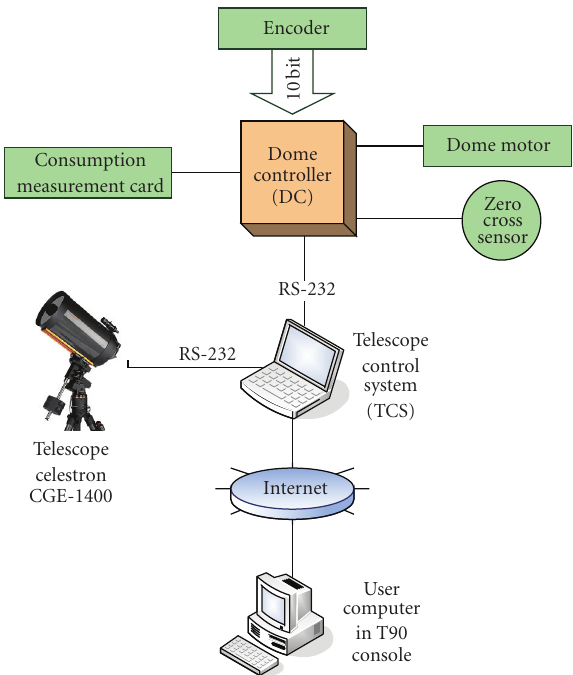
Figure 3: General block diagram of the